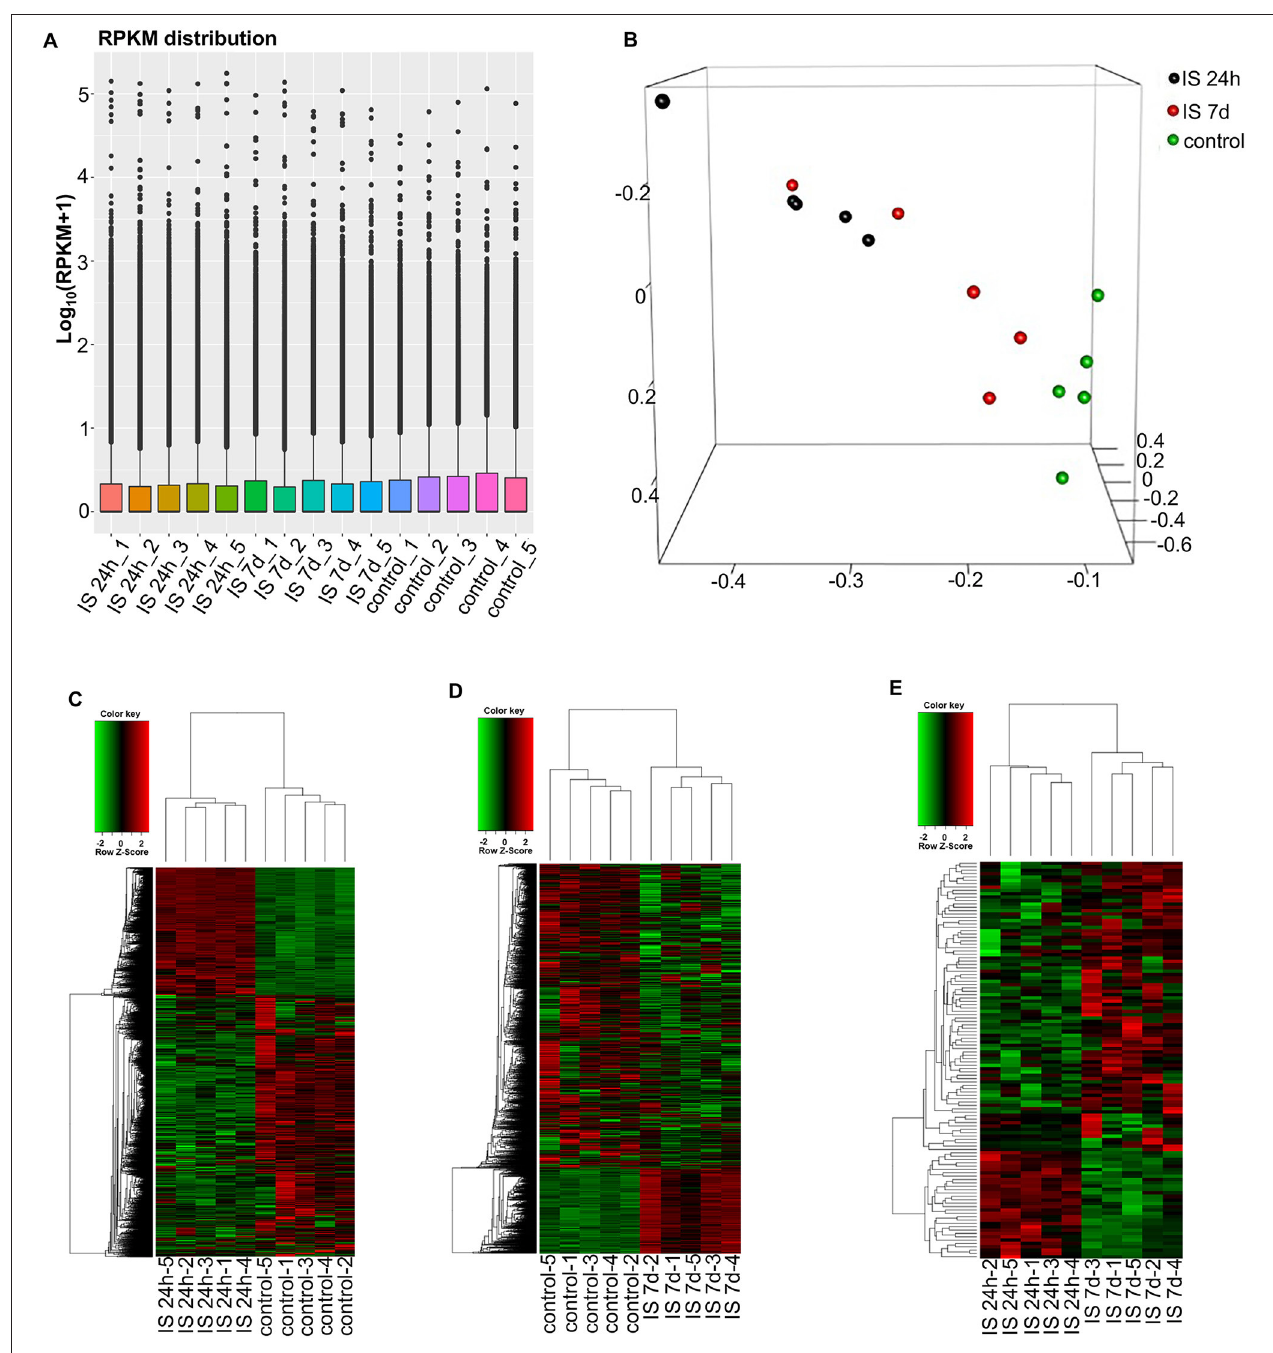
FIGURE 1 | RNA-seq analysis of mRNAs and LncRNAs in IS patients. (A) RPKM (reads per kilobase per million) distribution for LncRNAs in all PBMCs from IS patients and healthy controls. (B) Three-dimensional principal component analysis (PCA) of all 15 samples to evaluate the variability of RNA-seq data. The axes represent the principal components (PC1, PC2, and PC3). (C–E) Cluster analysis of differentially expressed LncRNAs and mRNAs of IS patients and healthy controls. (C) Hierarchical clustering analysis indicated 3,009 LncRNAs and 3,982 mRNAs that were differentially expressed between IS patients at 24h ( n = 5) and healthy controls ( n = 5), and the number decreased to 2,034 and 1,641 at 7 days, respectively (D) . (E) The heatmap shows that 73 LncRNAs and 36 mRNAs were differentially expressed between 24h and 7 days in IS patients. In the color scheme, red indicates higher expression, and green indicates lower expression.